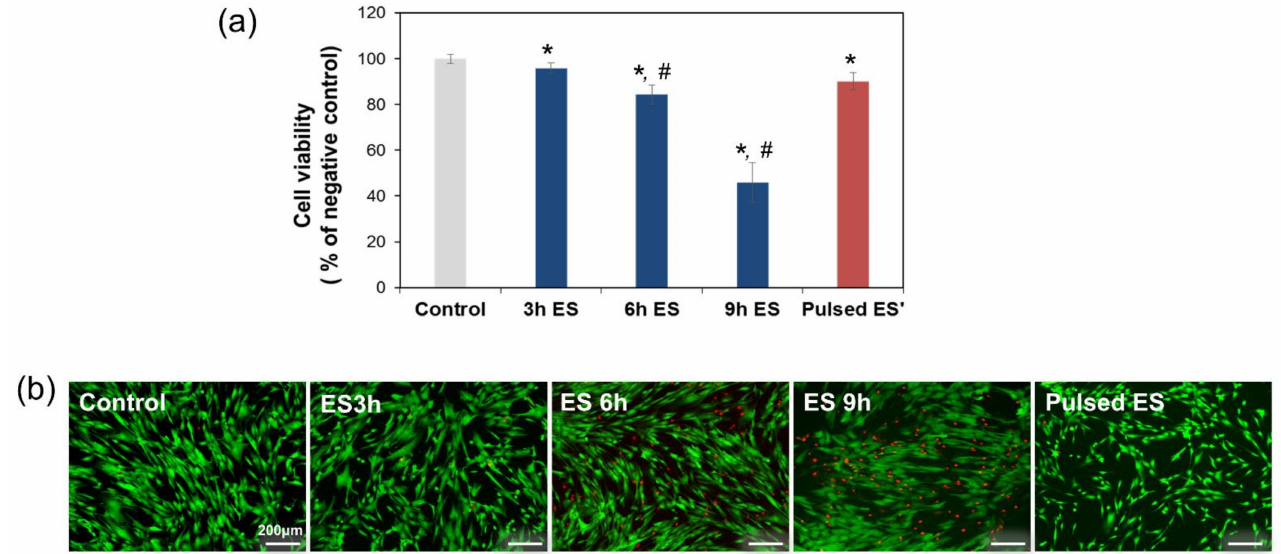
Figure 2. Effect of electrical stimulation (ES) on cell viability, as measured by the MTT assay ( a ) and Live/Dead assay ( b ) after 1200 µ A ES was applied for different prolonged exposure times. * represents p < 0.05 compared to controls not exposed to electric current. # represents p < 0.05 compared to cells subjected to 3 h